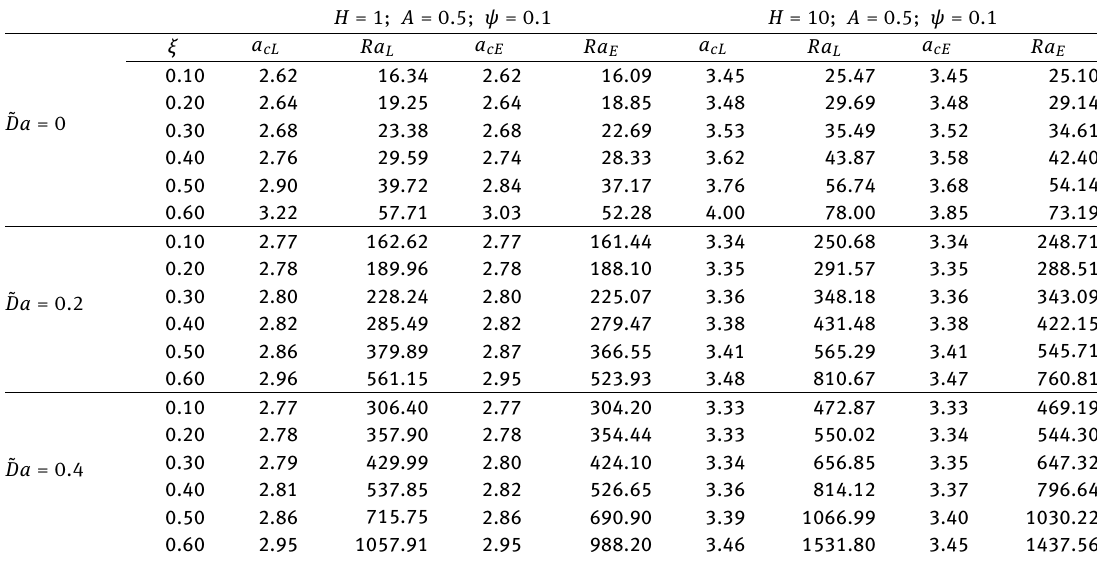
Table 5: Variation of critical Rayleigh number ( Ra L , Ra E ) with internal heat parameter ( ξ ) at fixed values of ˜ Da , H , A , ψ for case D of non- uniform heat